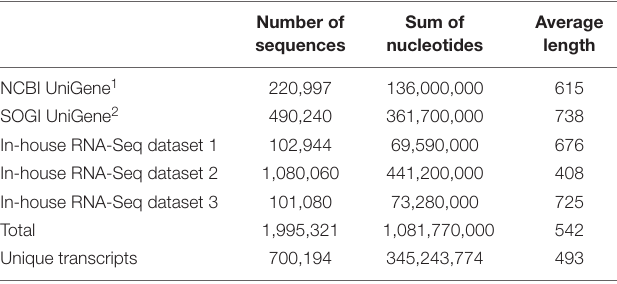
TABLE 1 | Sugarcane transcript database sources used for identification of sugarcane putative resistance genes.